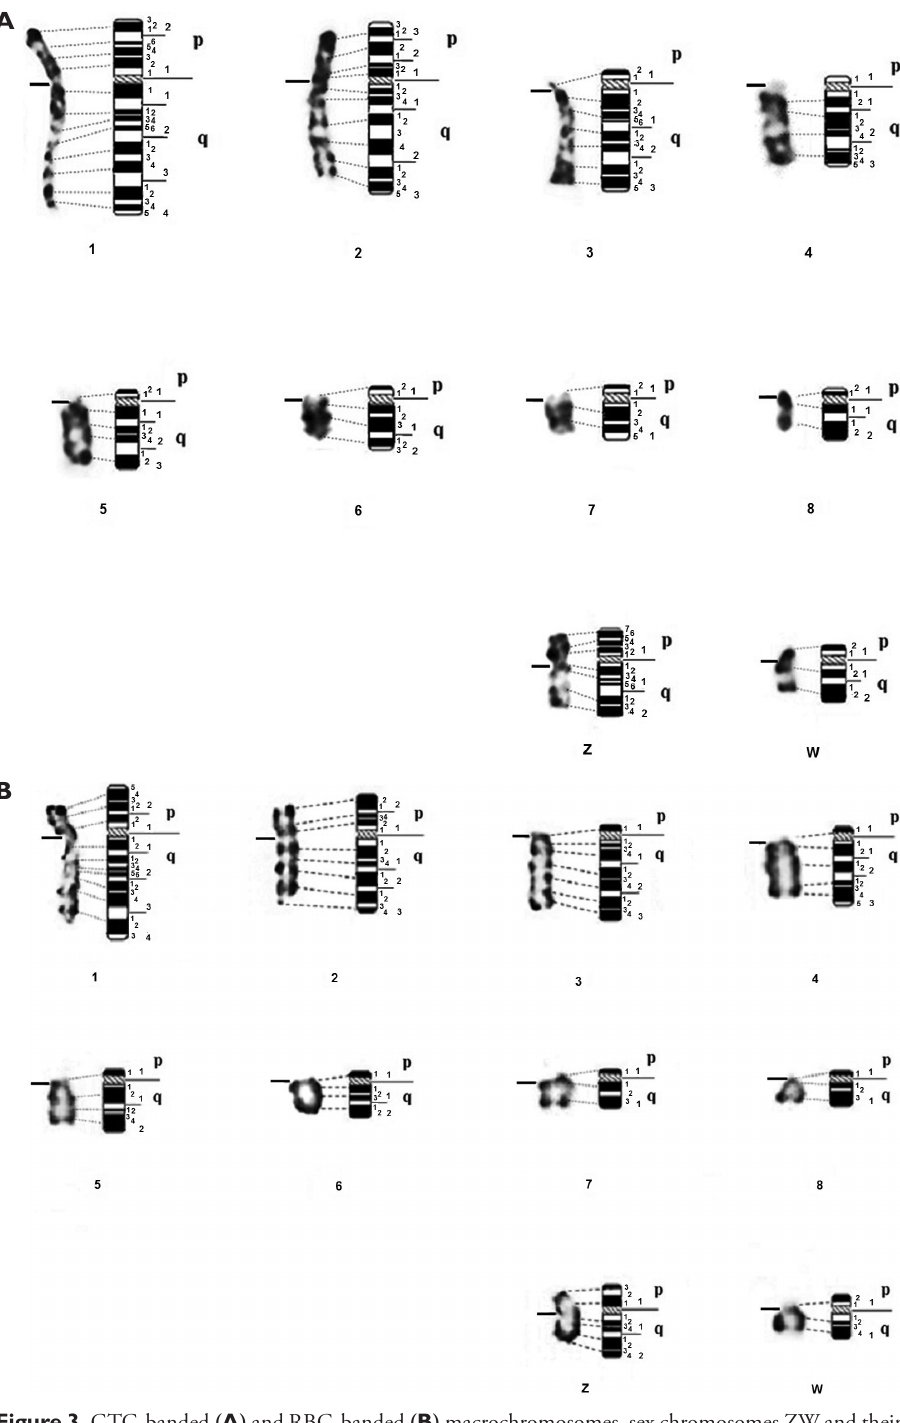
Figure 3. GTG-banded ( A ) and RBG-banded ( B ) macrochromosomes, sex chromosomes ZW and their corresponding ideograms of Houbara bustard Chlamydotis undulata undulata